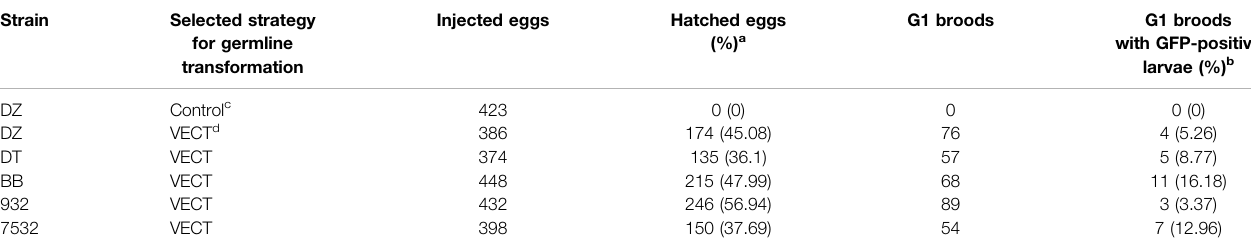
TABLE 1 | Statistical results of injecting a mixture of pBac and pHA3PIG vectors into silkworm embryos of different strains. Strain Selected strategy for